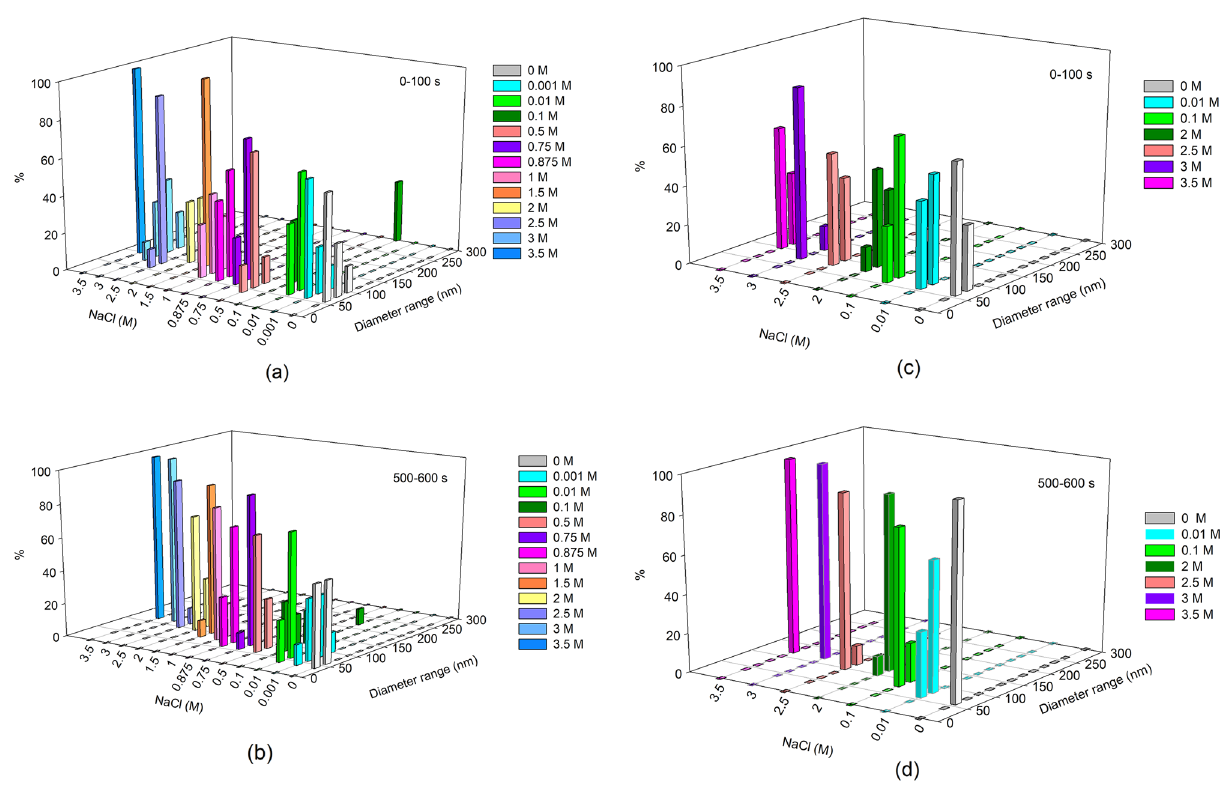
Fig. 3 Particle size distribution of QDs in suspensions as a function of NaCl (0.001–3.5 M) and the presence of SRNOM at 10 mg/L: a NaCl-QD systems within 0–100 s; b NaCl-QD systems at last 100 s; c NaCl-SRNOM-QD systems within 0–100 s; d NaCl-SRNOM-QD systems at last 100